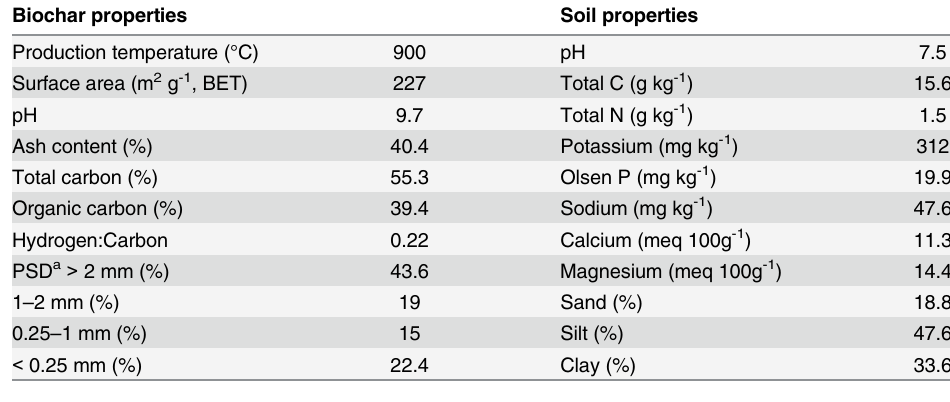
Table 1. Walnut shell biochar and soil (Yolo silt loam) physicochemical properties. Biochar